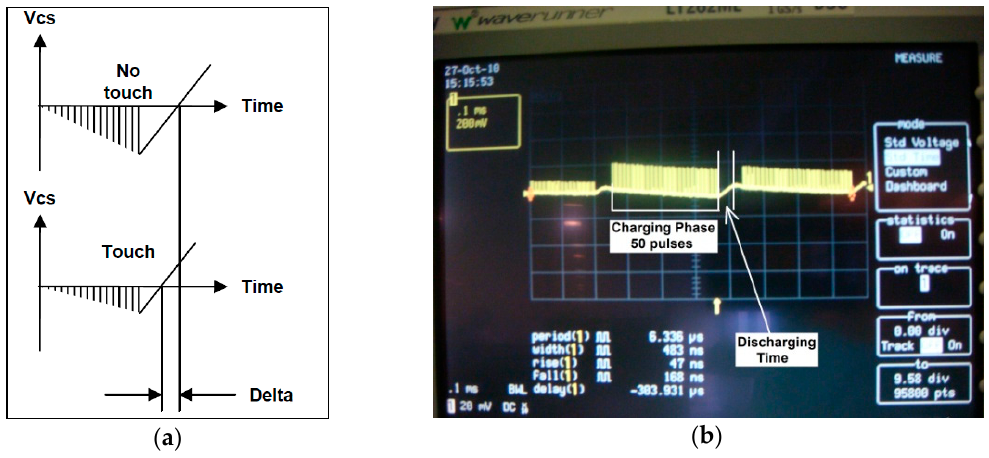
Figure 3. ( a ) Theoretical demonstration when a finger steals some of amount charge from the sensor; ( b ) Charge-discharge phase with 50 pulses.